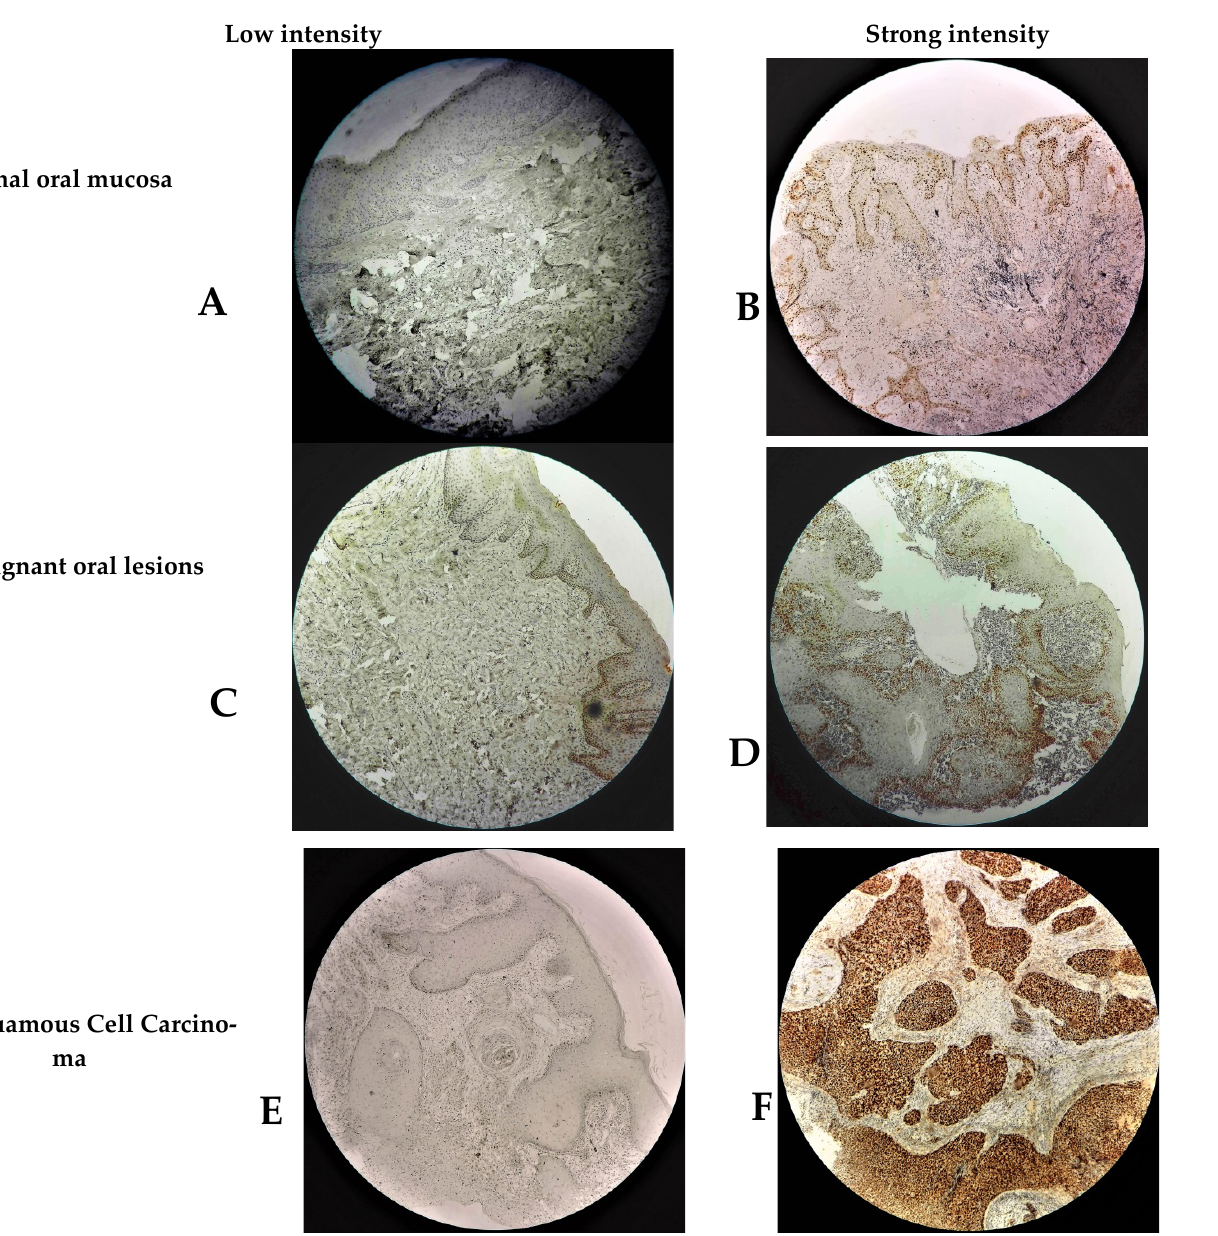
Figure 1. Staining intensity of proliferative oral epithelial cells showing weak and strong staining of proliferating cells of different oral lesions at the mean 92 cut-off. ( A , B ): low and strong intensity MCM3 expression in normal oral mucosa, respectively. ( C , D ): low and strong intensity MCM3 expression in PMOL, respectively. ( E , F ): low and strong intensity MCM3 expression in OSCC, respectively.